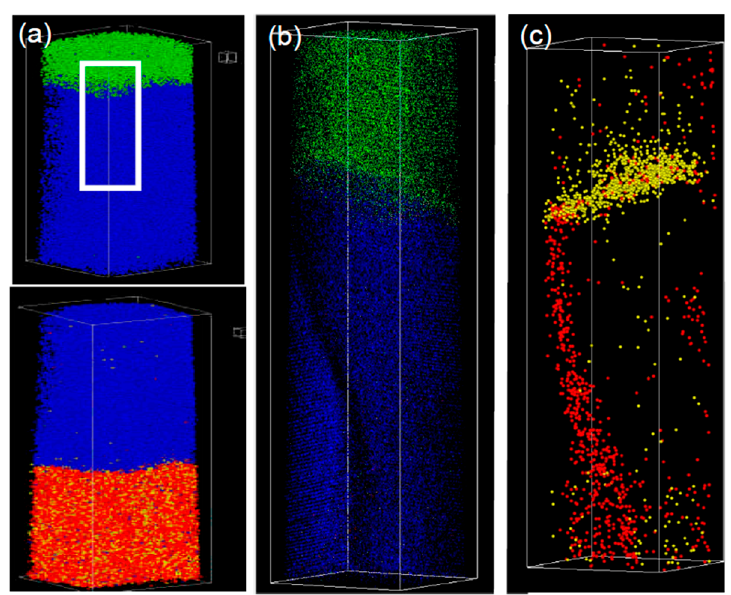
Figure 8. 3D reconstruction of atom probe tomography of a Fe (red) Ni (yellow)/Cu (blue)/Co (green) trilayer: ( a ) as prepared Co/Cu interface (upper image) as well as Cu/Py interface (lower image); ( b ) and ( c ) show the element distribution after annealing at 350 °C for 30 min for the marked Co/Cu interface region in ( a ) (adapted from [51]).